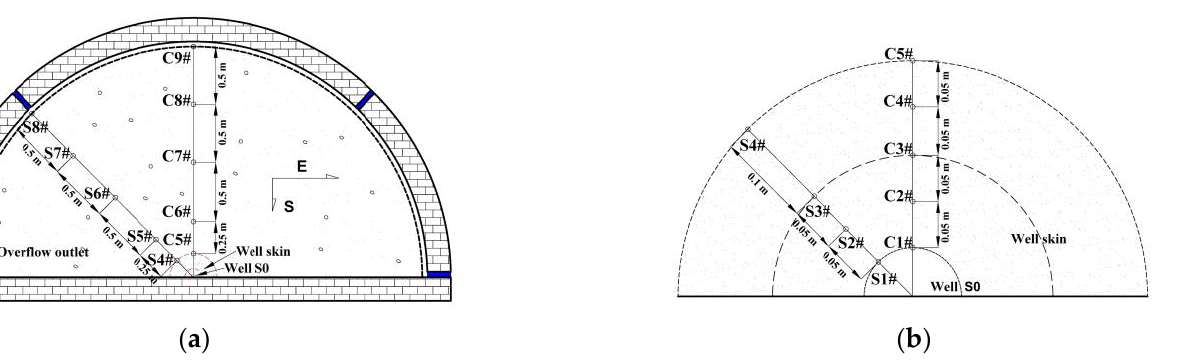
Figure 3. Indoor test platform planar graph. ( a ) Whole planar graph. ( b ) Well-skin planar graph.